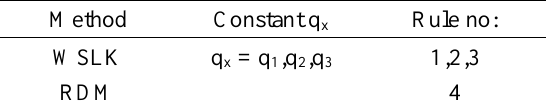
Table 2. Due-date assignment